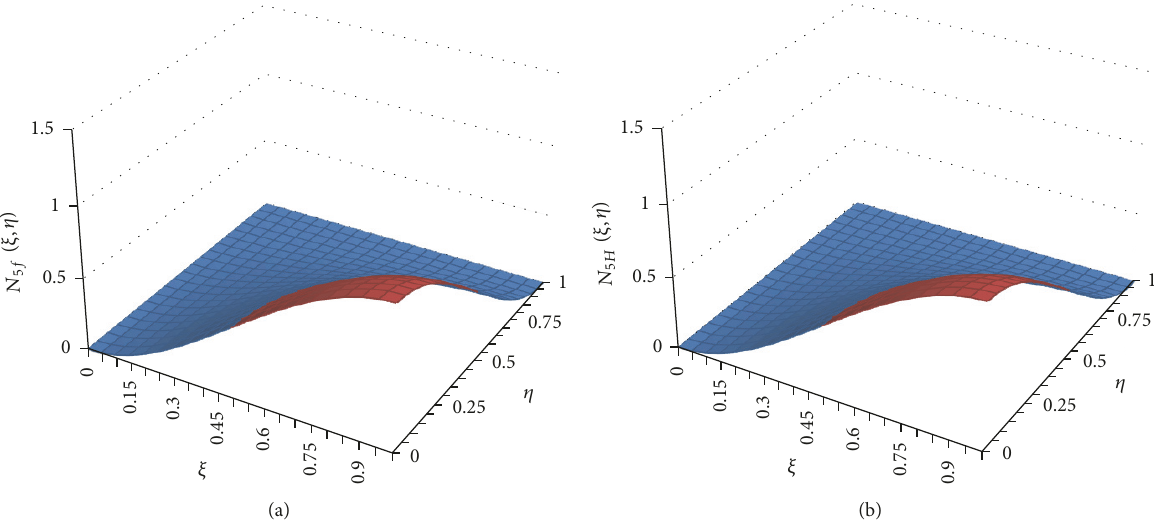
Figure 6: DFE (a) and FEM (b) shape function for 𝑤 2 at node 2.